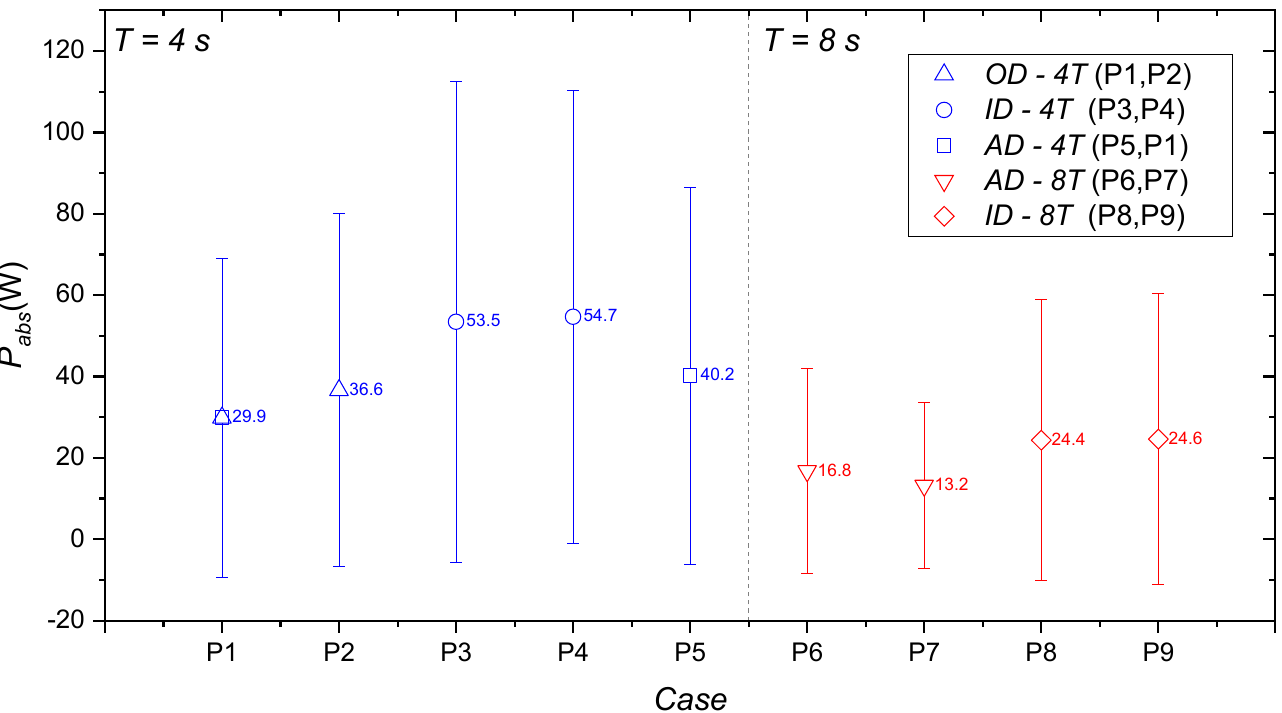
Figure 6. Mean absorbed power and its standard deviation for the sensitivity tests of the cases presented in Table 4 ( H = 1.0 m and R = 0.25 m), organized by wave period and the tested parameters.